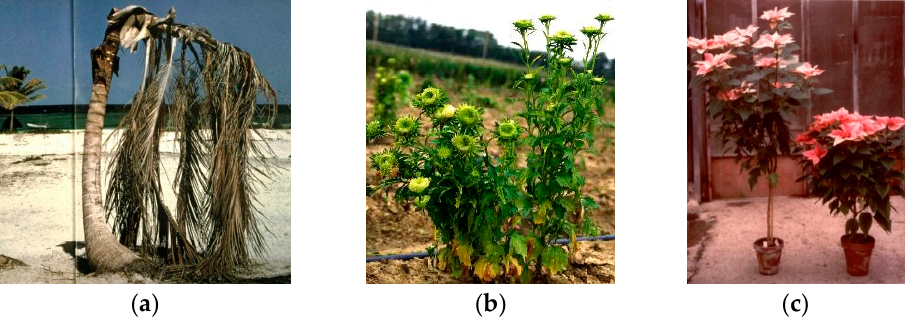
Figure 1. Coconut ( a ), aster ( b ), and poinsettia ( c ) infected by phytoplasmas.